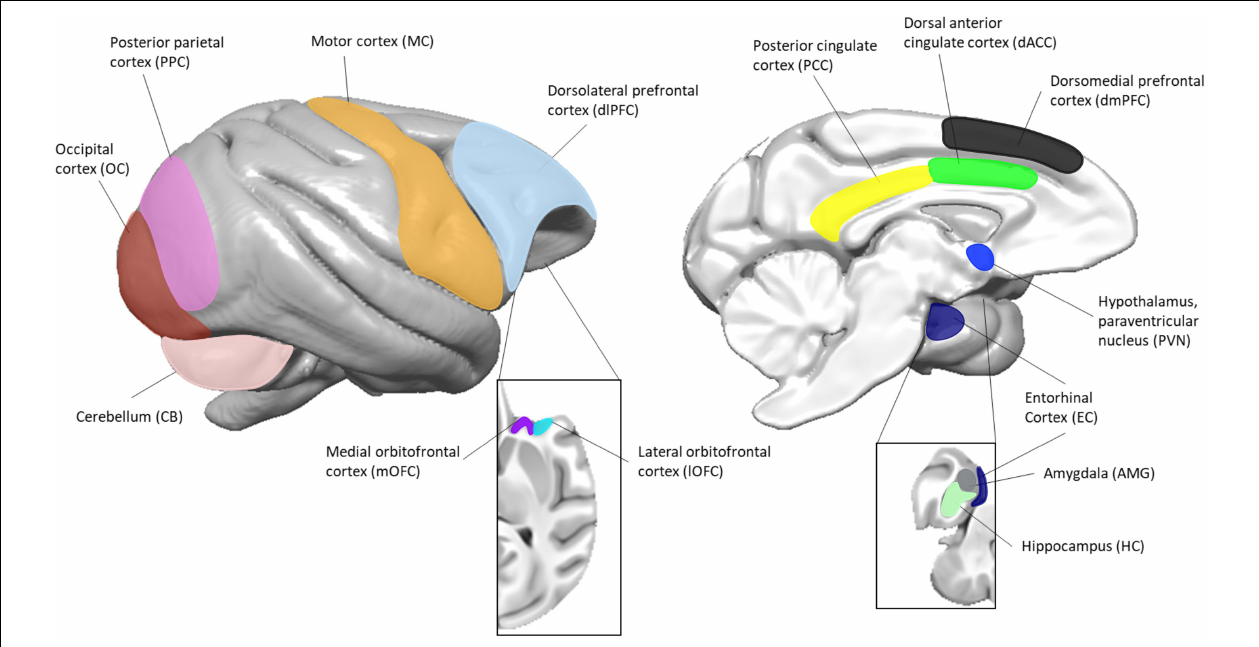
FIGURE 1 | Location of brain regions used in this study. The image to the left represents the lateral view and the image to the right represents the medial view. Insets are of the orbitofrontal (left) and mesial temporal (right) structures. Surface renderings of a published baboon brain template (Love et al., 2016) were created using MANGO